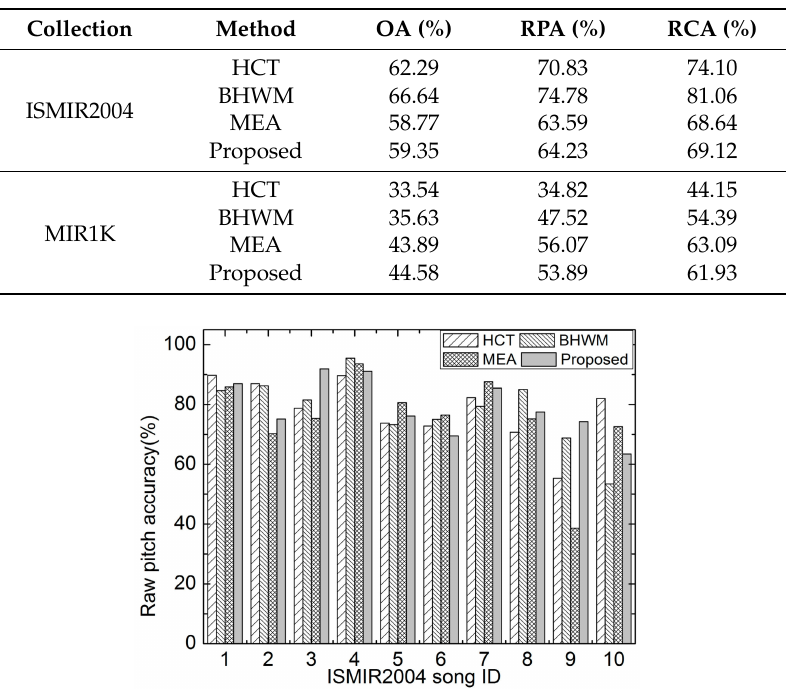
Figure 6. Raw pitch accuracies of different methods on